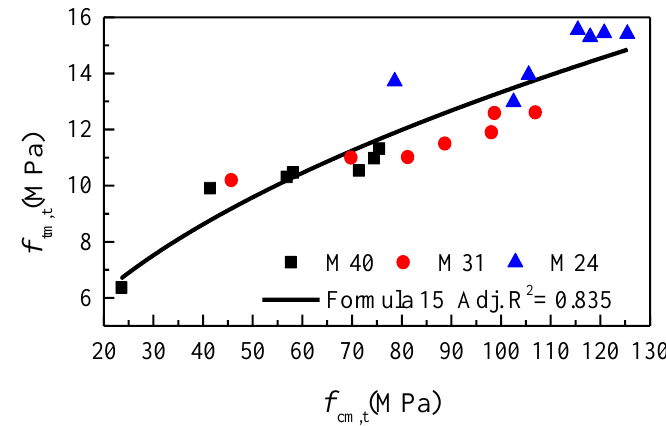
Figure 5. The relationship of flexural strength and compressive strength.